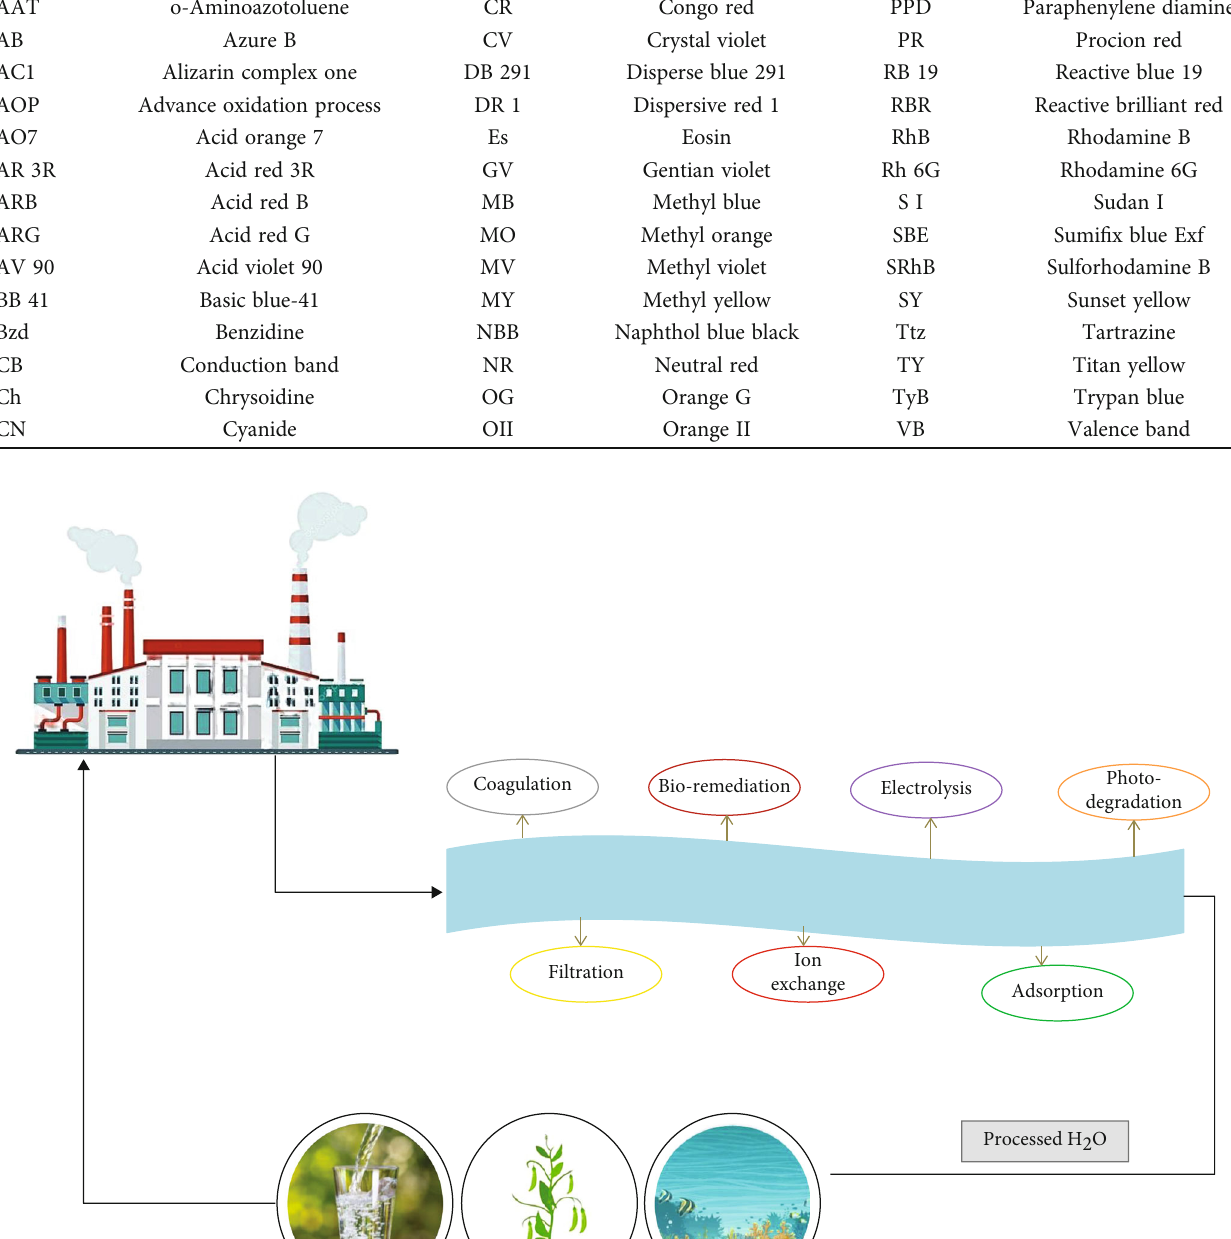
Table 1: List of some commonly used dyes and their